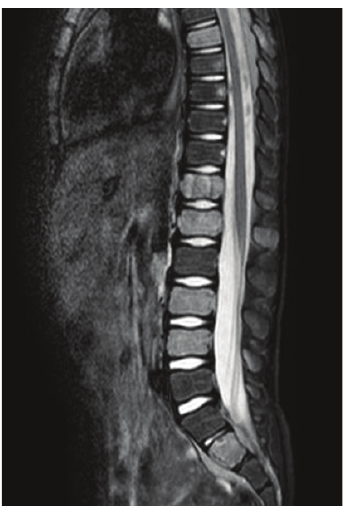
Figure 1: Spine MRI (median sagittal STIR): heterogeneous captation in some vertebrae (T7, T12, L1, L3, L4, S2), suggesting bone marrow infiltration.